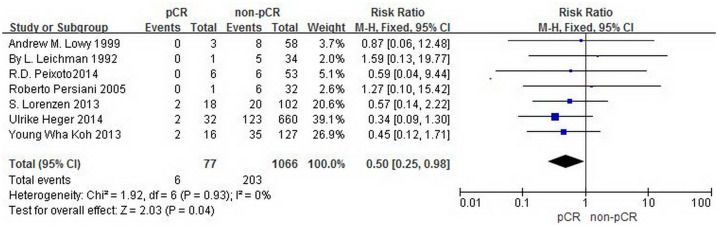
Forest plot of pooled relative risk for one-year OS from eligible studies.The area of each square represents the weighting, and the positions of each square demonstrate the risk ratio point estimate. Horizontal lines represent 95% confidence interval (CI). M-H = Mantel-Haenszel. Events = patients died from any cause within one year.